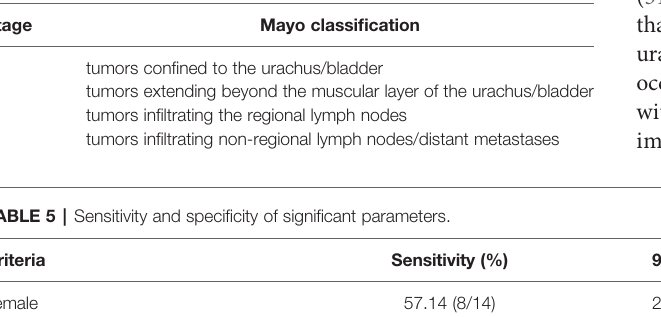
TABLE 4 | The Mayo staging system of urachal cancer.